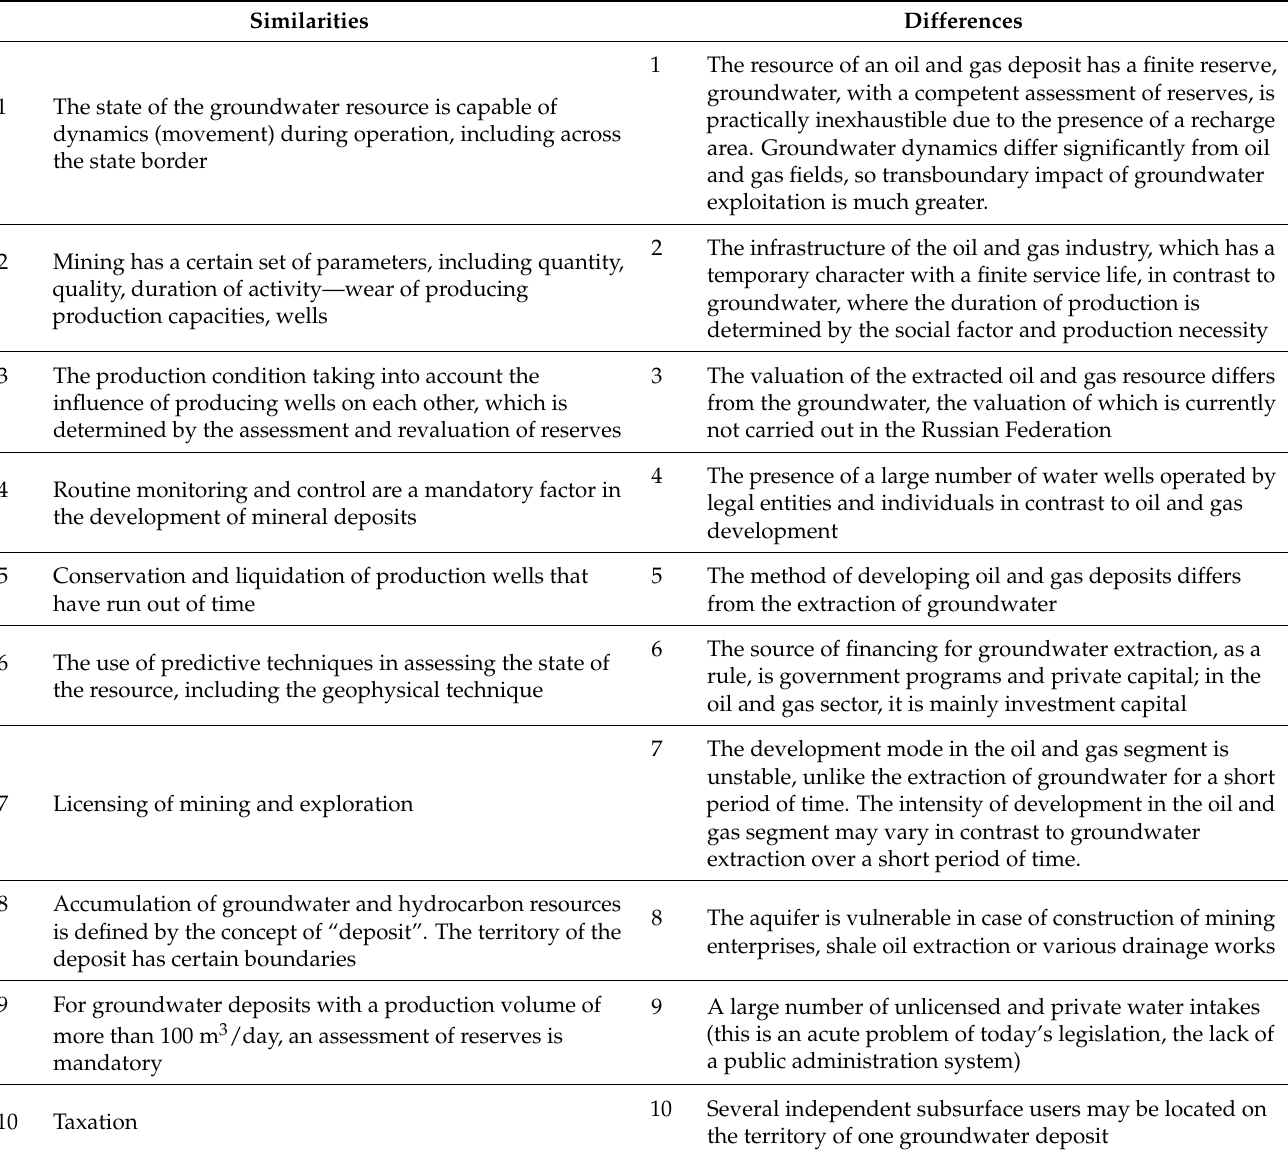
Table 1. Similarities and differences of unitization models in the field of oil and gas field development and groundwater